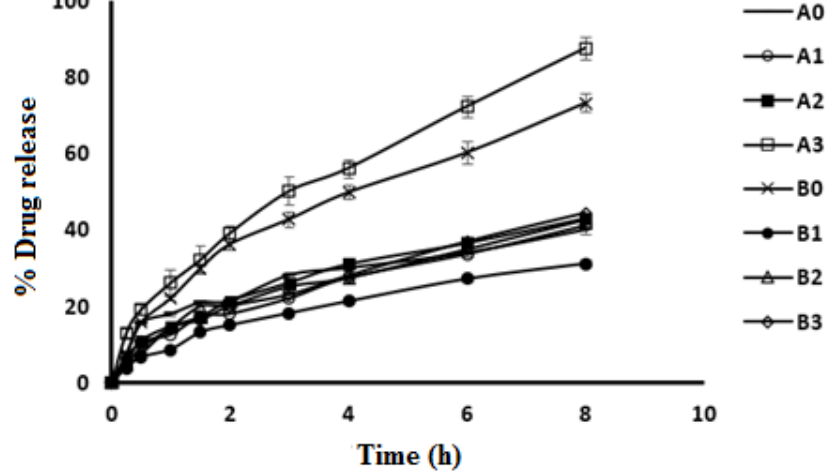
Figure 3. In vitro release profile of CPX from different ophthalmic CPX-CLBFs (mean ± SD, n = 3.0).